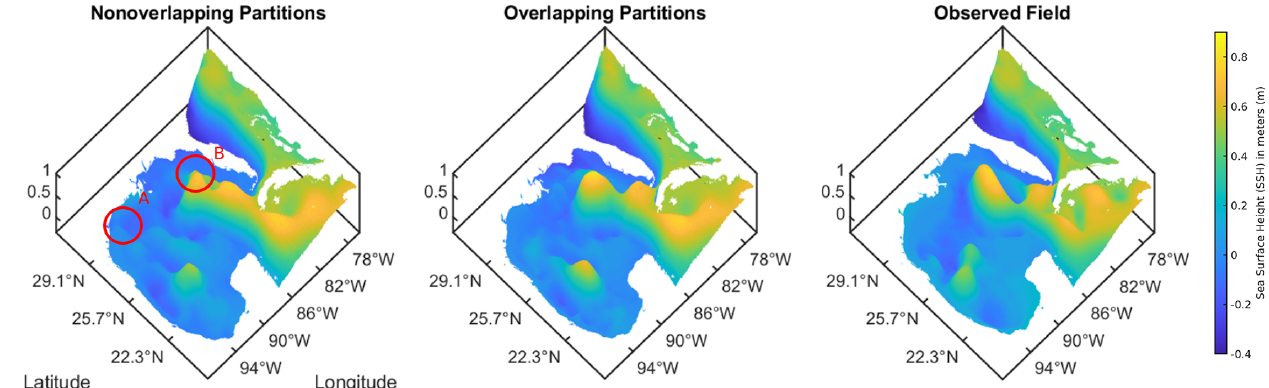
Figure 3. Example of discontinuity error effect on a 10-week SSH forecast. The left panel shows the SSH (m) prediction of the DAC model with no overlapping between partitions. The center panel shows the results of the DAC model with overlapping partitions. The right panel shows the HYCOM reference SSH. Red circles in the left panel shows two areas of interest, a trough (A) and a bump (B) where discontinuities have